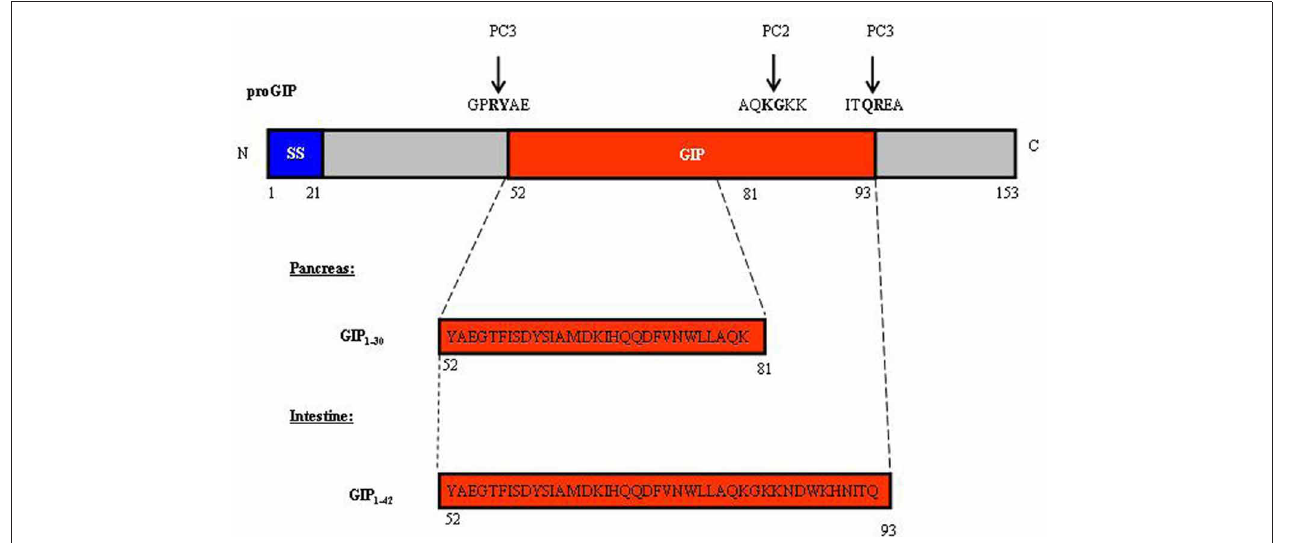
FIGURE 1 | Structure of proGIP and active GIPs. The proGIP, encoded by the gip gene, is a pro-hormone with 153 amino acid residues. The main circulating active hormone GIP 1 − 42 (aa 52–81) is generated predominantly in